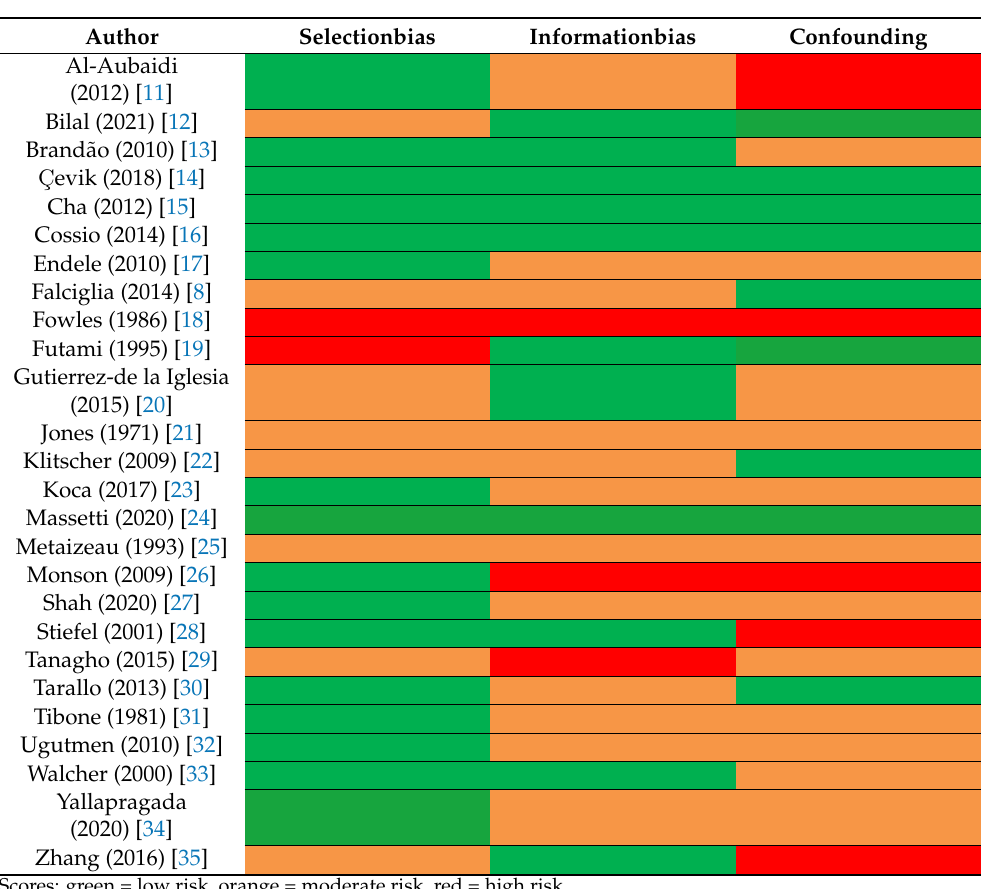
Table 2. Risk of bias assessment based on adapted Cochrane